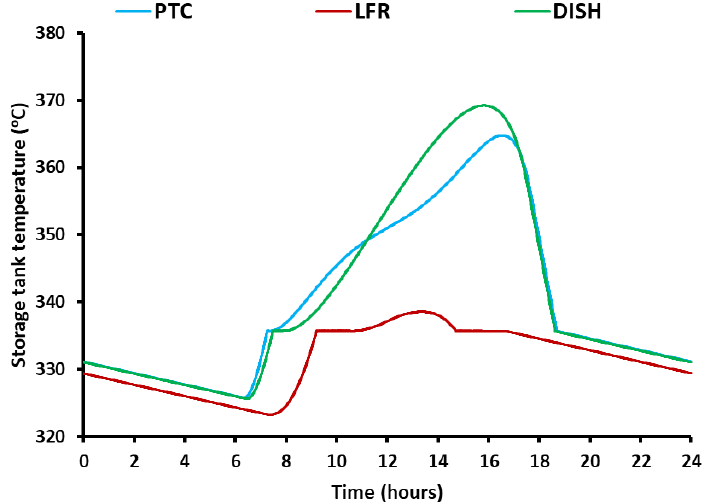
Figure 6. Daily variation of the useful heat production for the three collectors in June. Figure 7. Daily variation of the storage tank mean temperature for the three collectors in June.